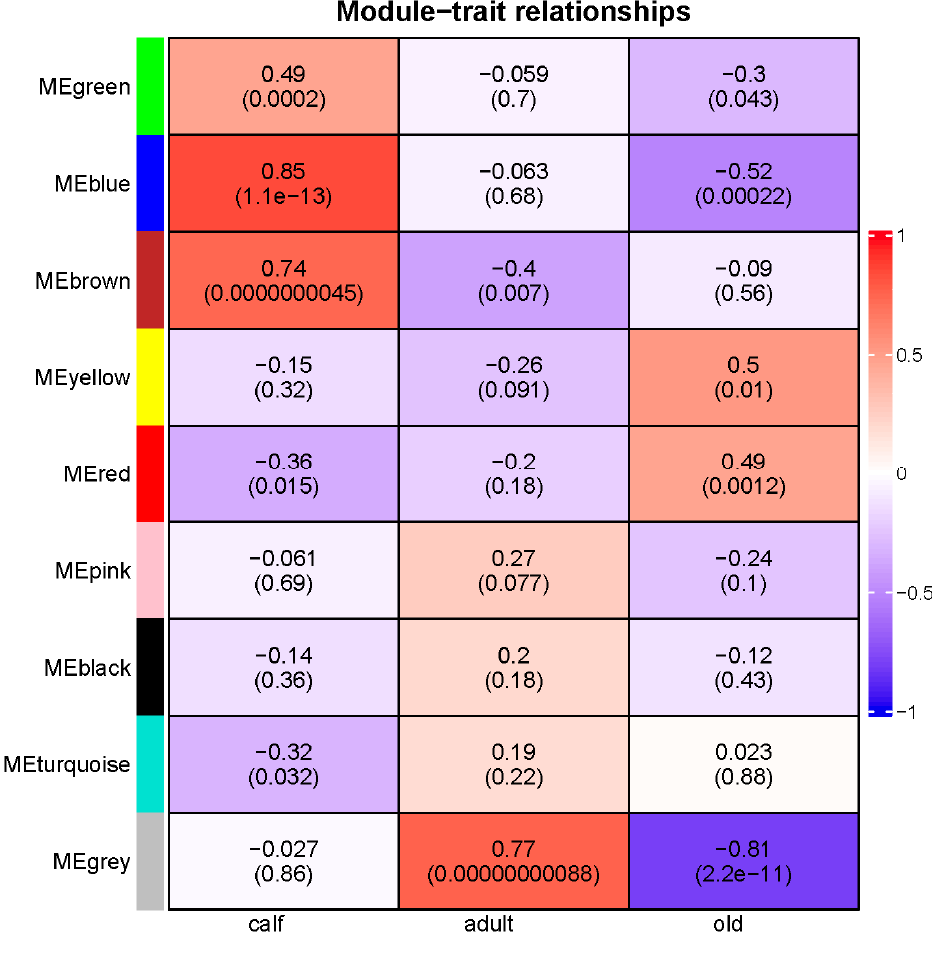
Figure 3. The correlation between the differentiation period and the modules. Red is positive and blue is negative.